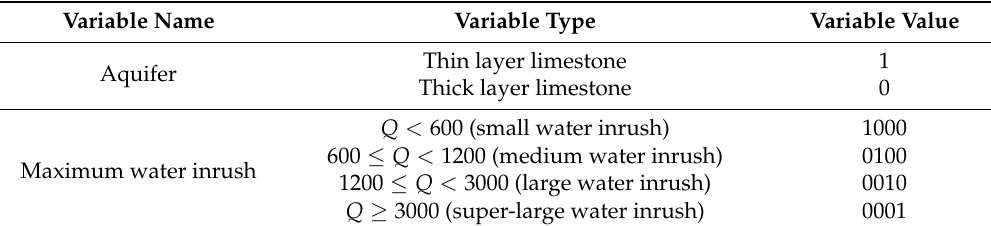
Table 2. Definition of the aquifer and the maximum water inrush volume.